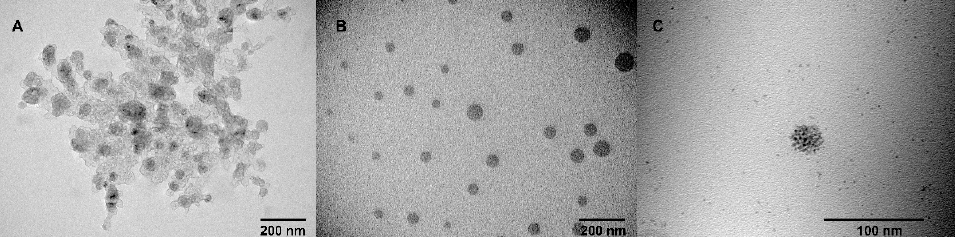
Figure 2. IR spectra (KBr pellets) of 1 ( a ), 2 ( b ), and mixture of 1 , 2 after cross-linkage ( c ). Figure 3. TEM images of empty polymeric particles ( 1 + 2 ) ( A ) and polymeric particles decorated with Pd ( B , C ).